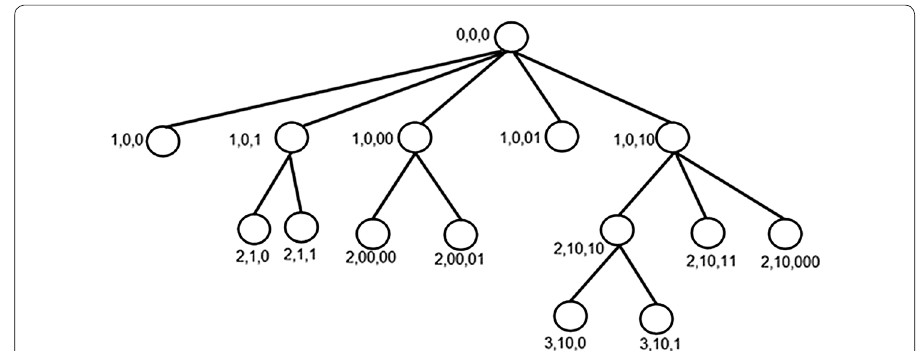
Fig. 1 An XML tree labeled by the proposed